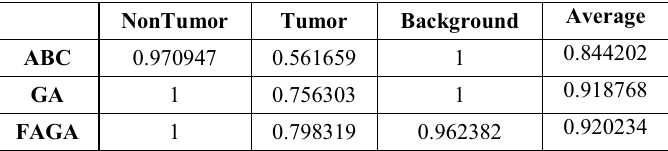
Table 3. Performance comparison using second image in terms of accuracy